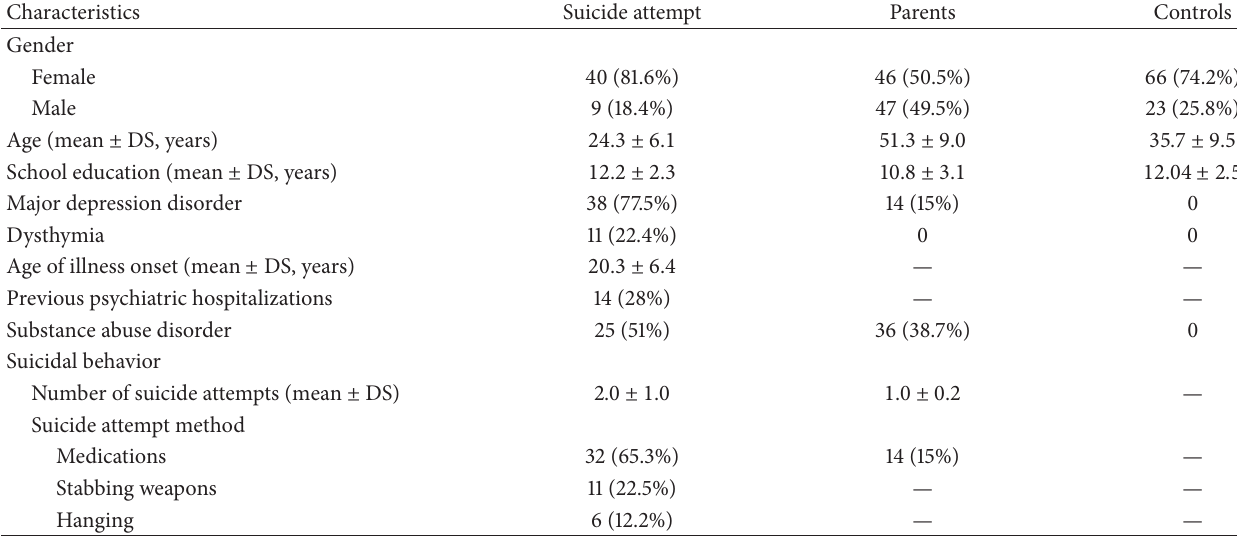
Table 1: Demographic and clinical characteristics of the sample.